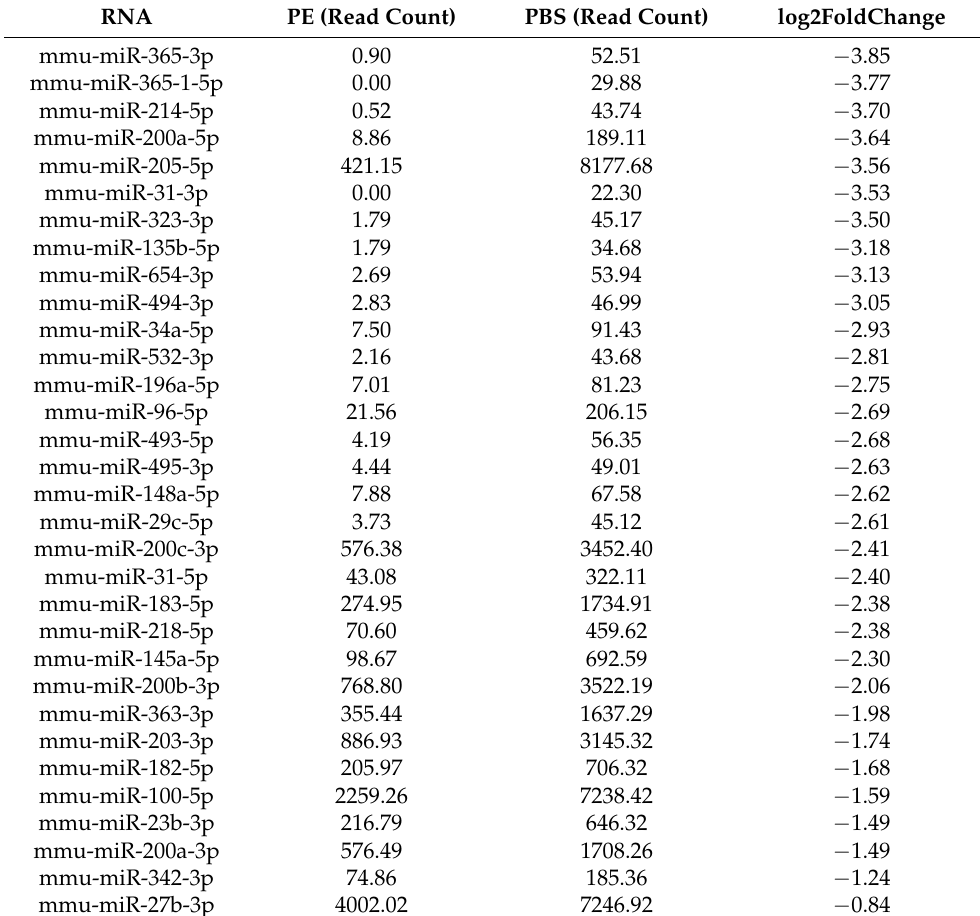
Table 2. miRNAs with significant down-regulation in blood serum EVs with PE (30 mg/kg/day) infusion for 1 week versus PBS. RNA PE (Read